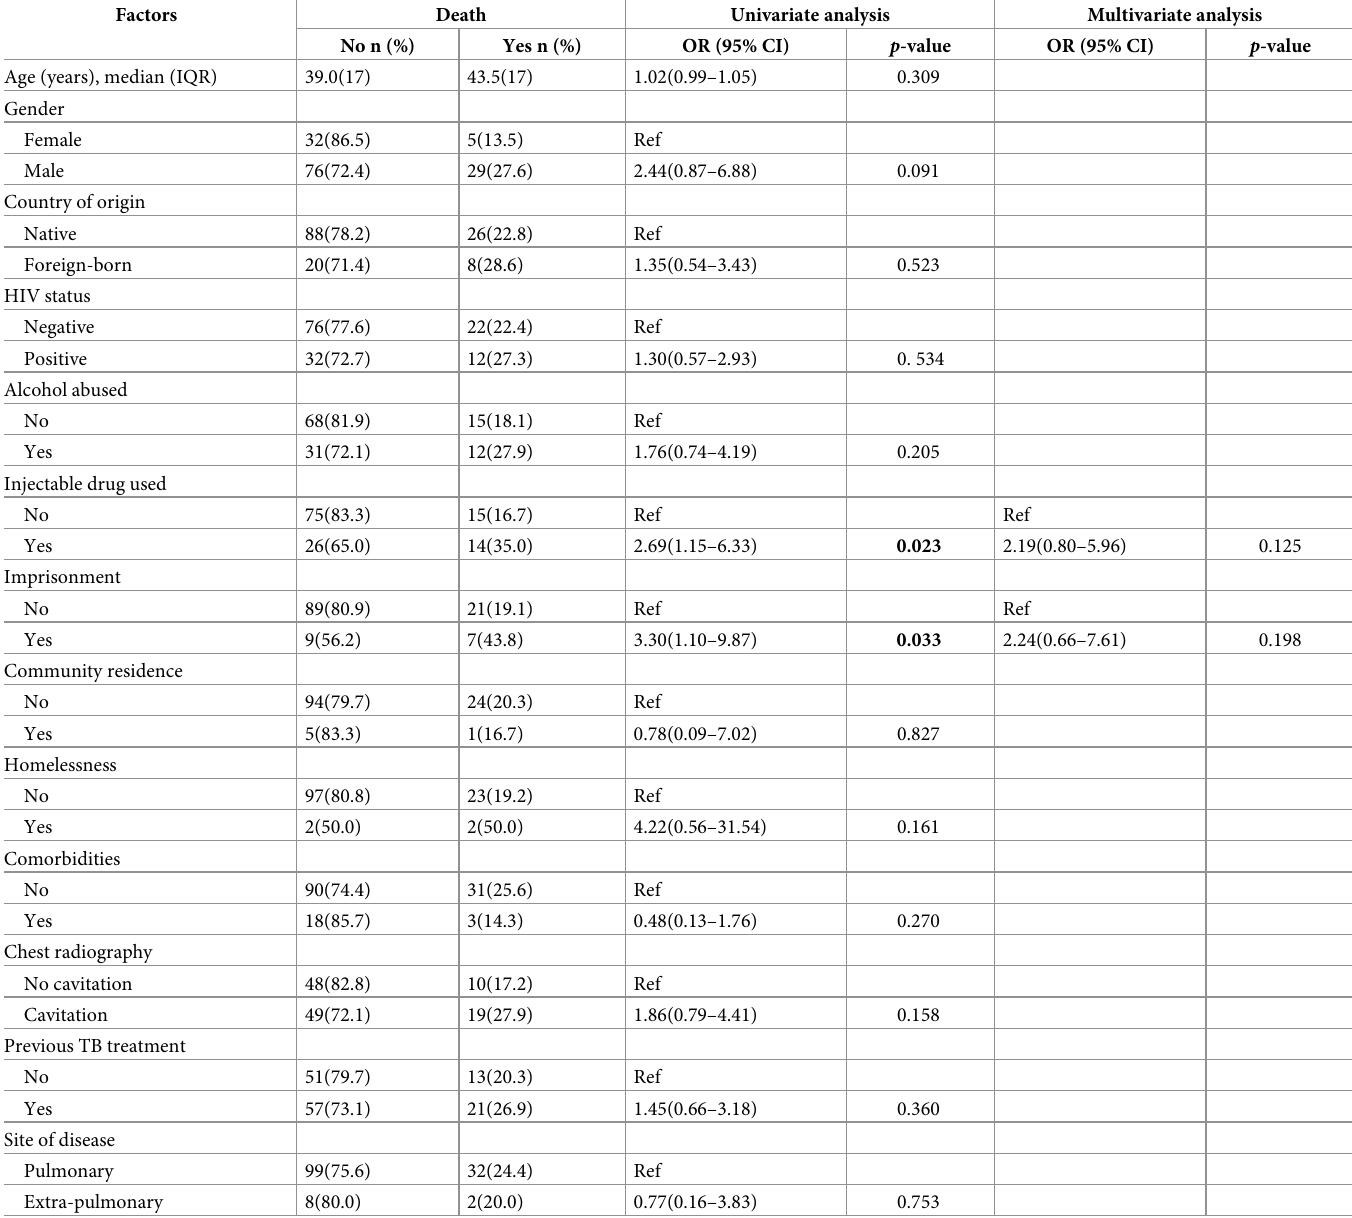
Table 4. Factors associated with death among patients with extensively drug-resistant tuberculosis (n =